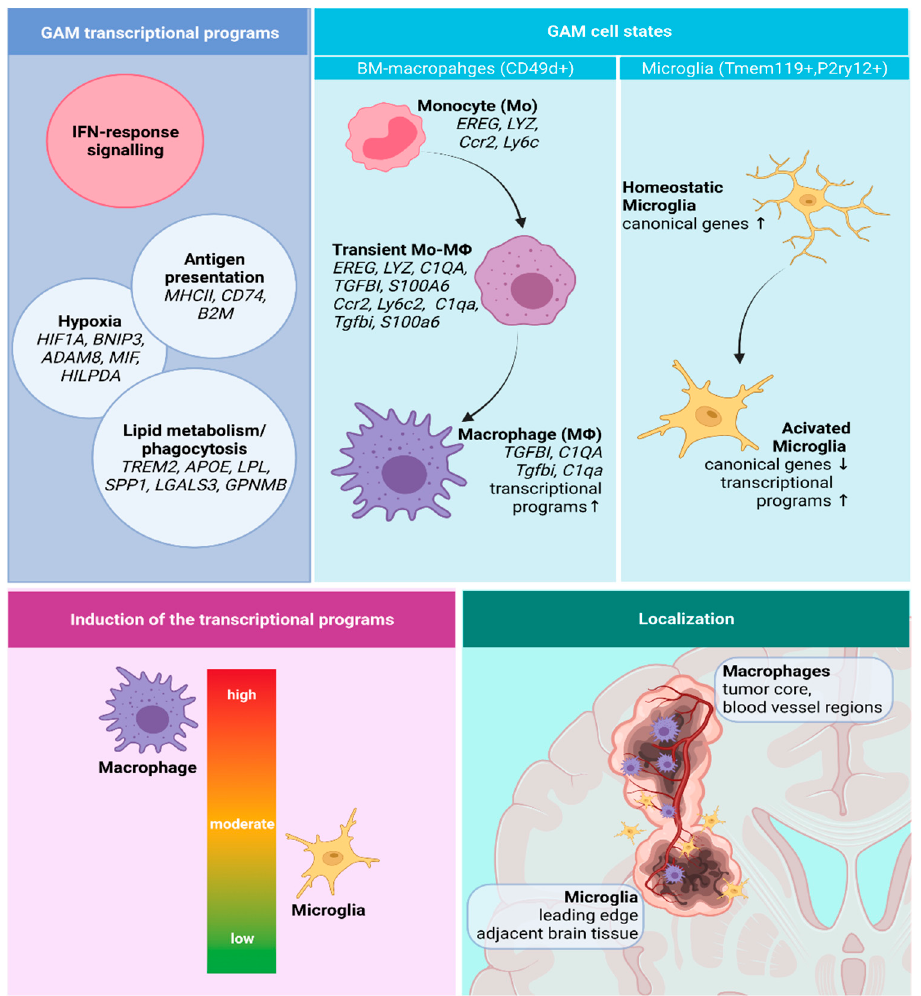
Figure 2. A summary of the identified transcriptional programs, cell states, and spatial distribution of GAMs. Created with Biorender.